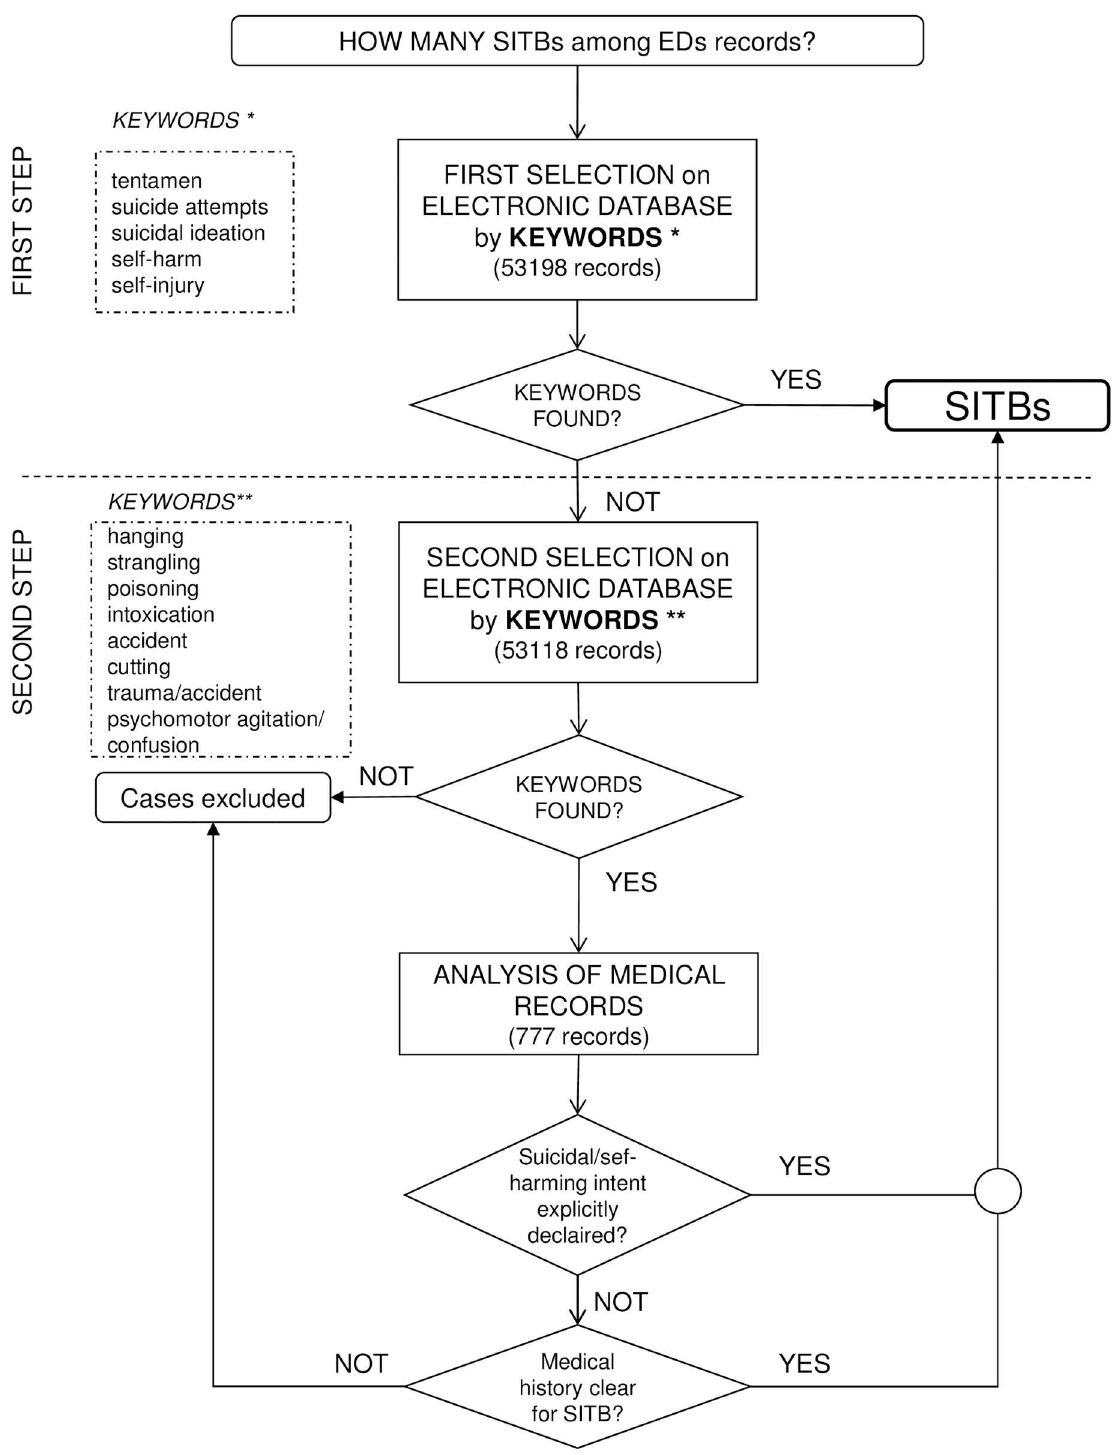
Fig 1. Flow-chart representing the two-steps procedure for the identification of SITBs among the cases visited in the EDs of the Friuli Venezia Giulia Region in the years2005 and 2006.